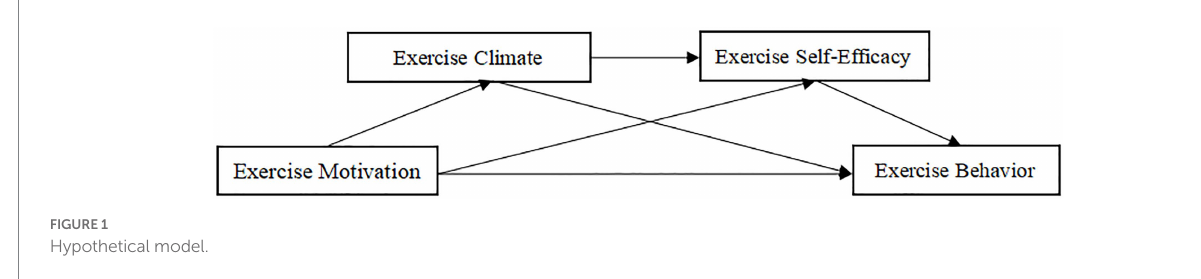
FIGURE 1 Hypothetical model.